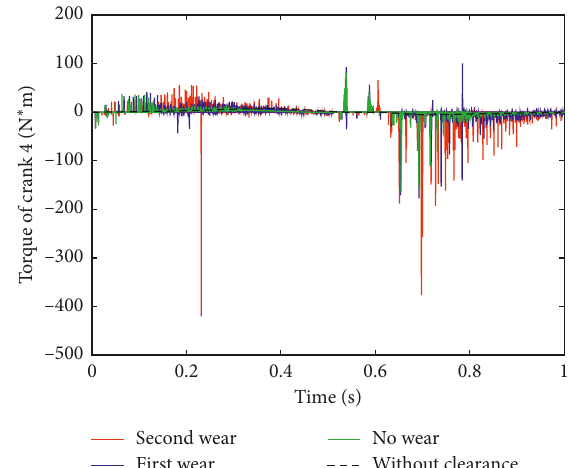
Figure 19: Slider’s acceleration.